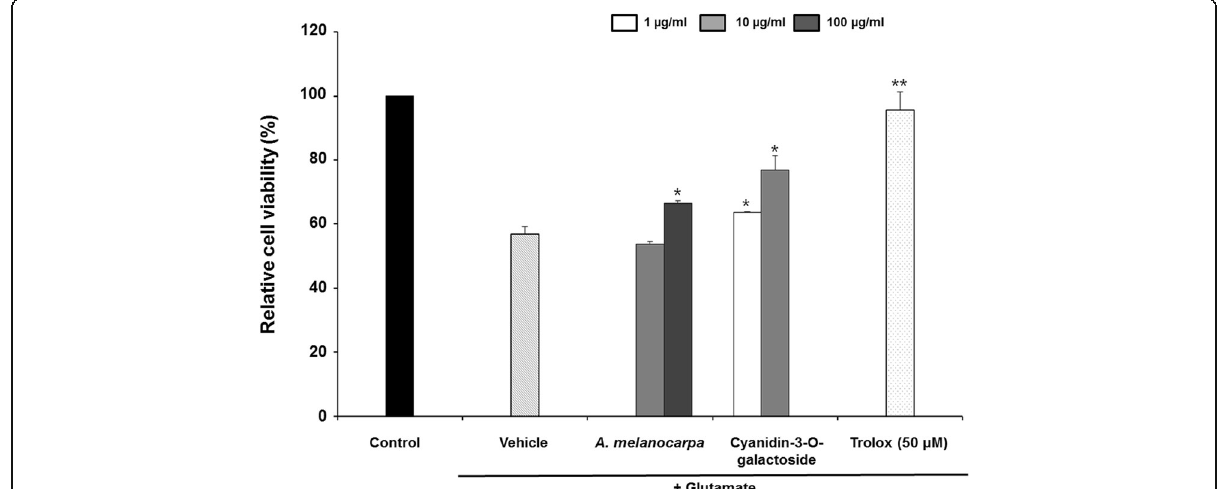
Fig. 1 Effect of A. melanocarpa extract (10 and 100 μ g/ml) and cyanidin-3-O-galactoside (1 and 10 μ g/ml) on glutamate-induced death of HT22